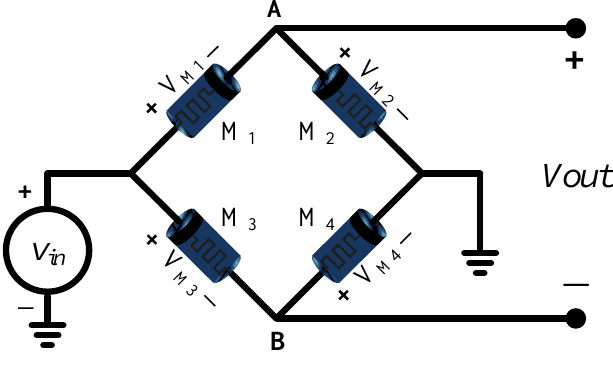
and M are incrementally biased 2 3